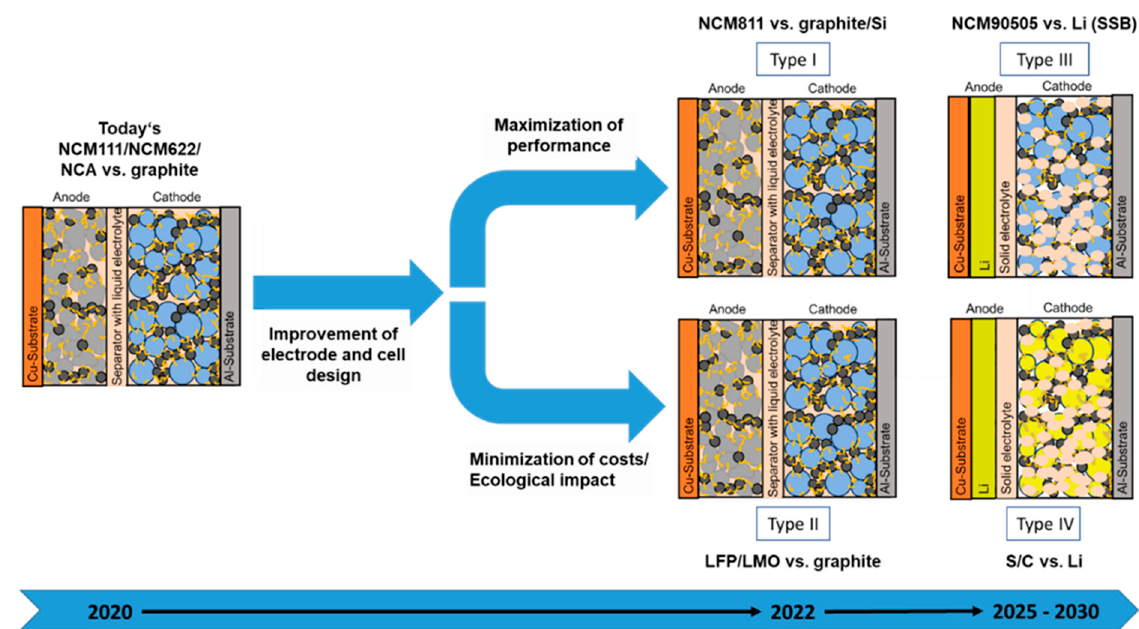
Figure 2. Diversification of lithium battery technologies.